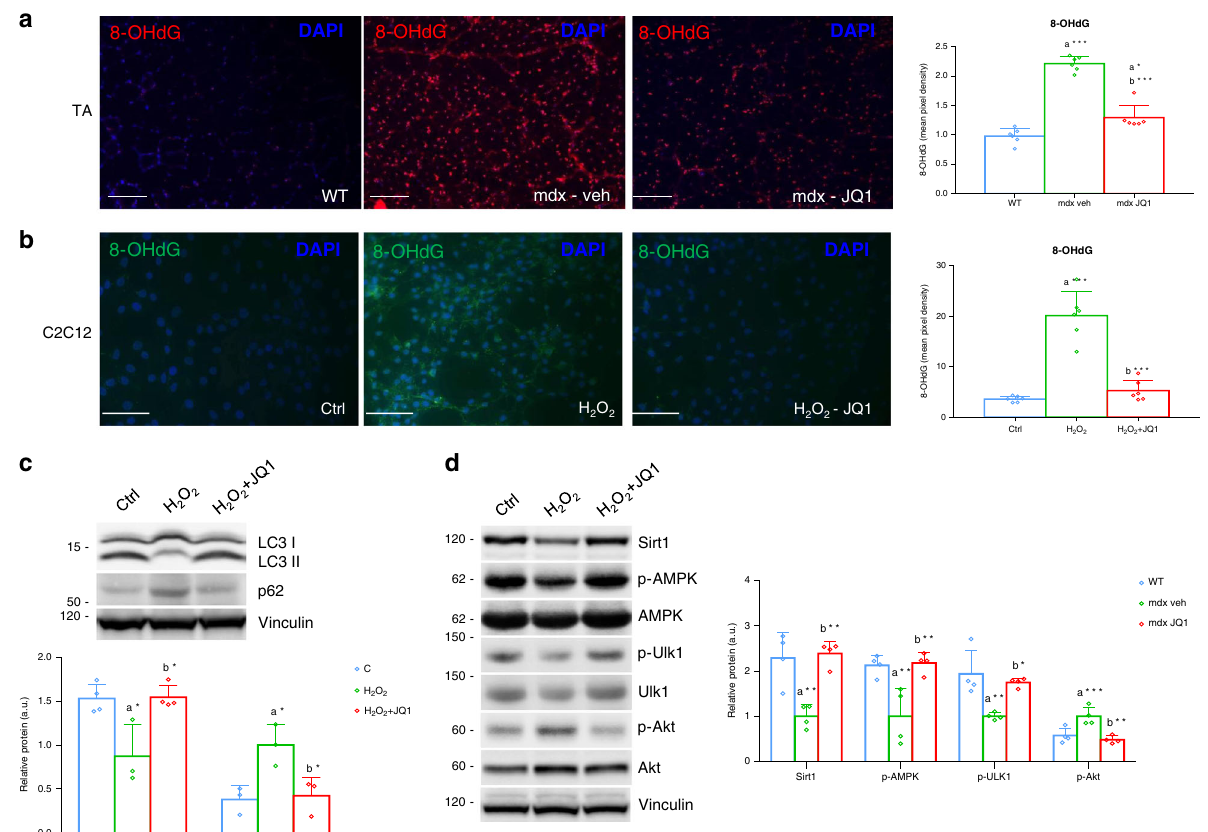
Fig. 4 JQ1 decreases oxidative stress in the mdx muscle and in H 2 O 2 -treated cells. a Representative images of 8-OHdG staining of muscle cross-sections in control, vehicle- and JQ1-treated TAs ( n = 6 sections examined from n = 3 animals for each experimental group). Scale bar: 50 µ m. Right panel: quanti fi cation of the staining. Data are expressed as a mean ± SD. a indicates statistical signi fi cance compared to Control group; b indicates statistical signi fi cance compared to the mdx mice animal group. b Representative images of 8-OHdG staining of C2C12 cells. Cells were pretreated with JQ1 (200 nM) for 24 h and then stimulated with H 2 O 2 for 24 h. Scale bar: 50 µ m. Right panel: quanti fi cation of the staining derived from three independent experiments. n = 6 fi elds examined from n = 3 independent experiments. Data are expressed as a mean ± SD. a indicates statistical signi fi cance compared to Control cells; b indicates statistical signi fi cance compared to the H 2 O 2 -treated C2C12. c Representative western blot for LC3 ( c , n = 4; H 2 O 2 , n = 3; H 2 O 2 + JQ1, n = 4) and p62 ( n = 3 independent experiments) in C2C12 myotube extracts of control and H 2 O 2 - and H 2 O 2 /JQ1-treated cells for 24 h. Myotubes were pretreated with JQ1 (200 nM) for 24 h and then stimulated with H 2 O 2 for 24 h. In order to study the autophagy fl ux, the experiment was performed by pre-treating cells with 30 µ M of the lysosomotropic agent chloroquine. Vinculin serves as a loading control. Right panel: quanti fi cation of normalized band intensity derived from three different experiments. Data represent means ± SD. a indicates statistical signi fi cance compared to Control cells; b indicates statistical signi fi cance compared to the H 2 O 2 -treated C2C12. d Representative western blot for Sirt1, p-AMPK, AMPK, Ulk1, p-Ulk1 (Ser555), Akt, p-Akt (Ser473) in C2C12 myoblast extracts of control and H 2 O 2 - and H 2 O 2 /JQ1-treated cells. Myotubes were pretreated with JQ1 (200 nM) for 24 h and then stimulated with H 2 O 2 for 24 h. Vinculin serves as a loading control. Right panel: quanti fi cation of normalized band intensity derived from at least four different experiments. Data represent means ± SD, n = 4 independent experiments. a indicates statistical signi fi cance compared to Control cells; b indicates statistical signi fi cance compared to the H 2 O 2 -treated C2C12. In all panels, statistical analysis was assessed by using one-way ANOVA followed by Tukey ’ s post hoc test. * P < 0.05; ** P < 0.01; *** P <